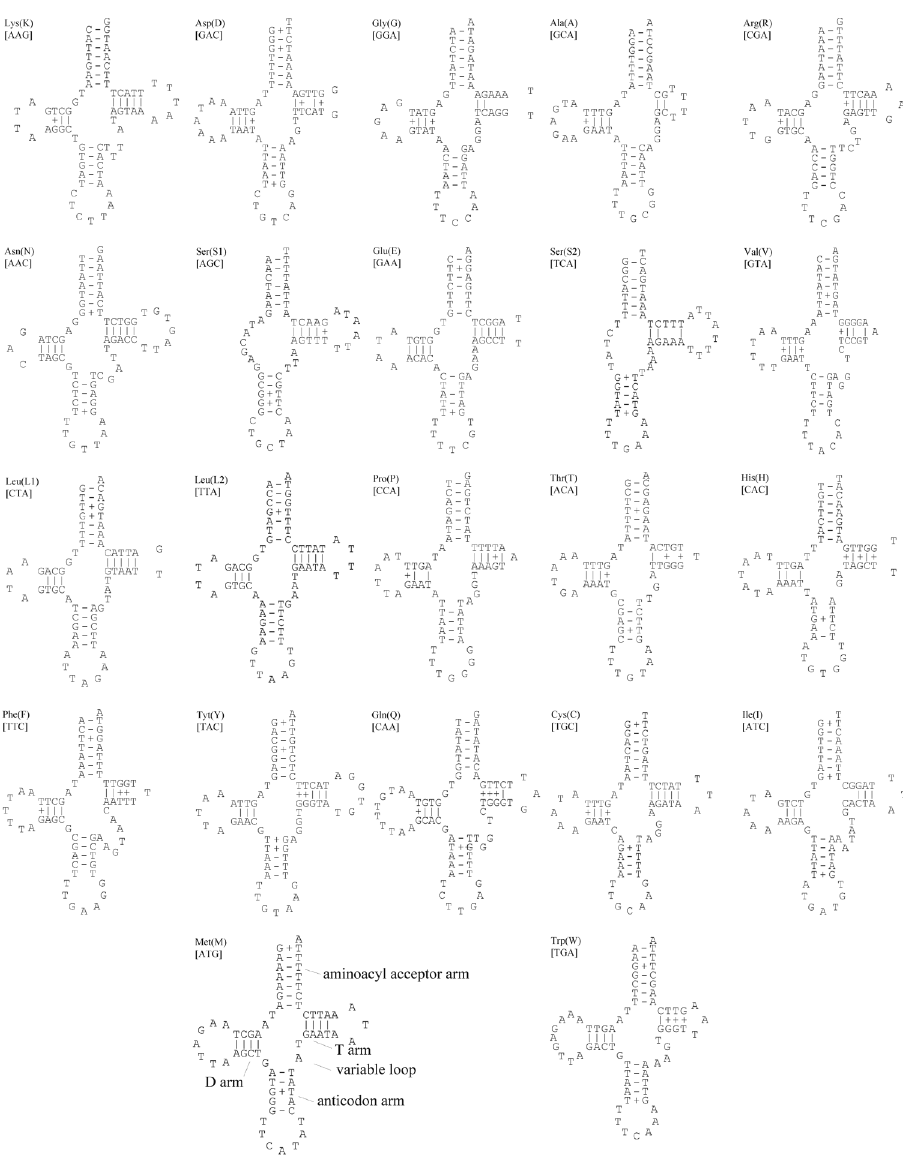
Figure 3. Putative secondary structures of the 22 tRNA genes of Asiomorpha coarctata. Watson-Crick base-pairing is indicated by solid lines, and G–T pairs are indicated with plus